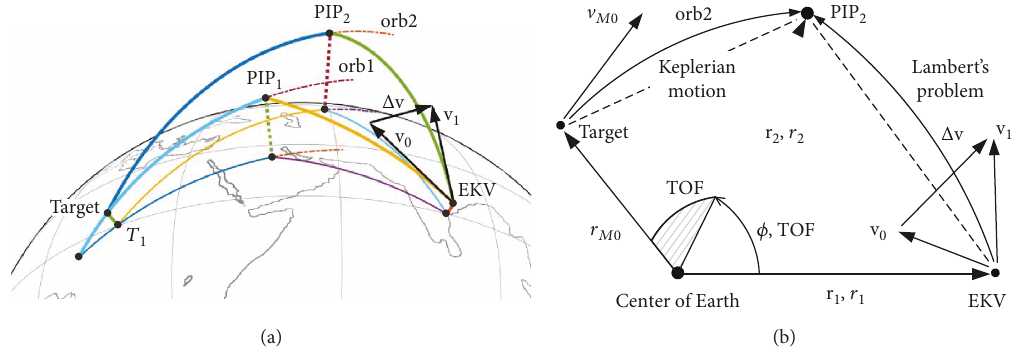
Figure 1: Illustration of the MVIP. (a) Geometry of exoatmospheric interception. (b) The MVIP is a combination of Lambert ’ s problem and Keplerian